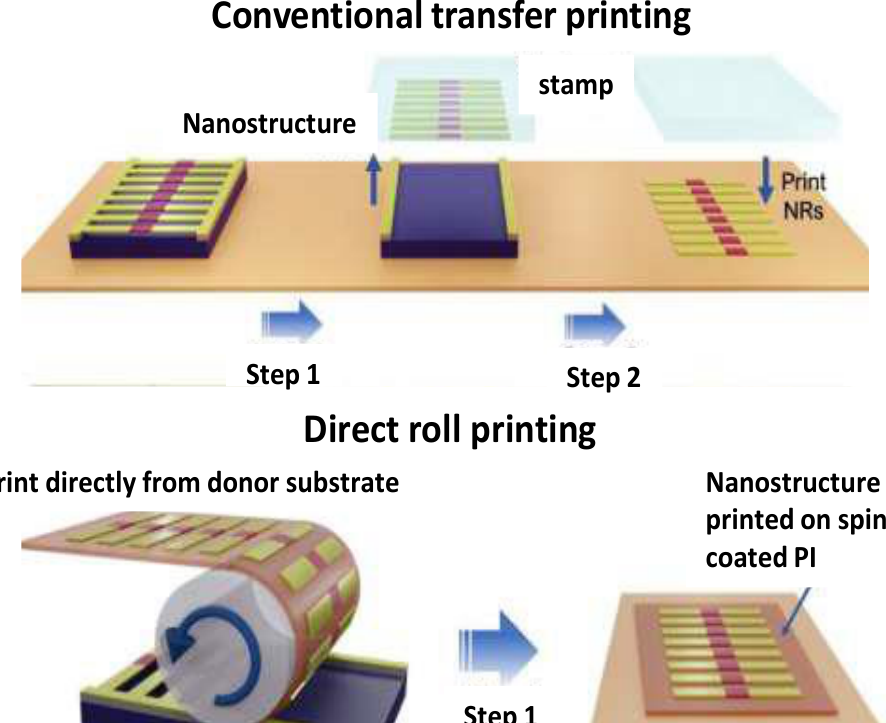
Figure 3. Representation of the most common technologies for the preparation of flexible electronics: conventional transfer printing and direct roll printing. Adapted from ref. [15,17].